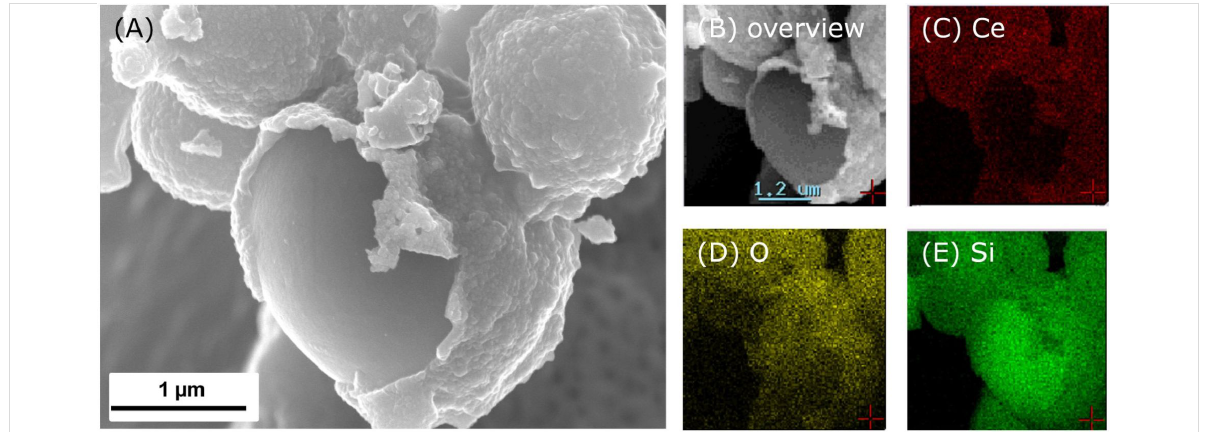
Figure 5: Elemental mapping investigations on CeO 2 /Si(O)C core–shell nanoparticles prepared by impregnation.